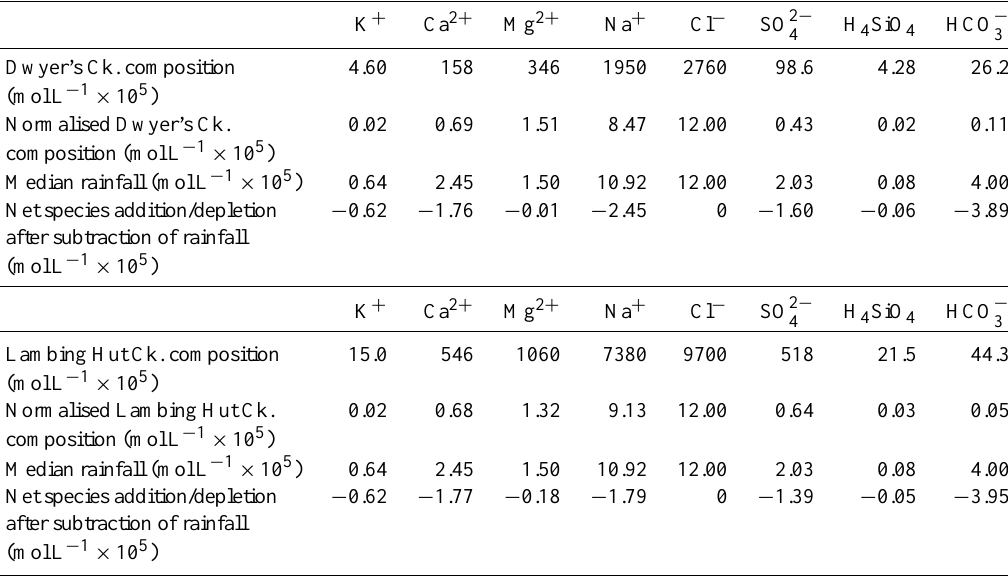
Table 6. Subtraction of rainfall input from surface water